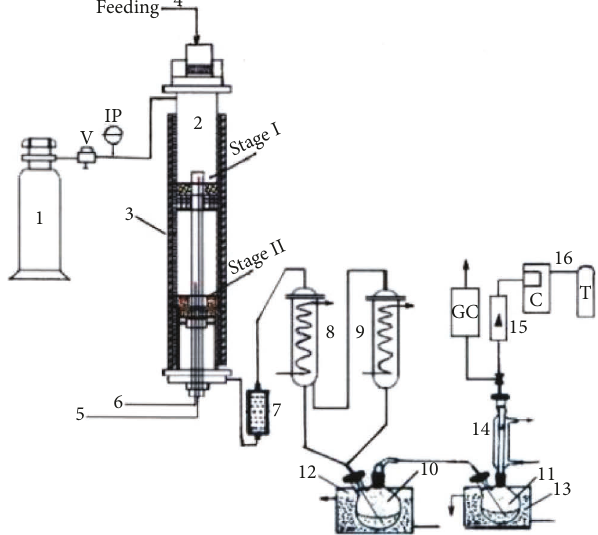
Figure 2: Scheme of experimental setup for biomass pyrolysis.